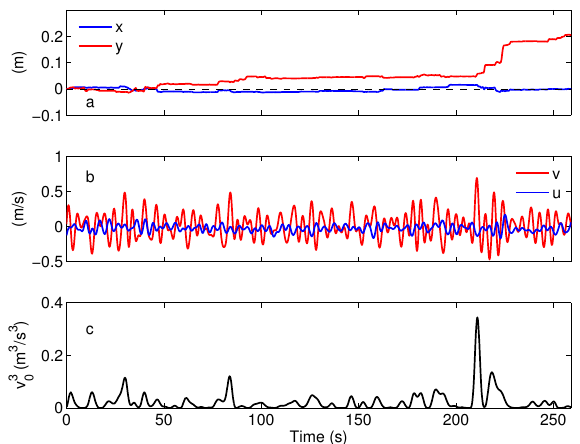
Figure 14. (a) Cross-shore y and along-shore x bed material dis- placements, from the time integral of the MFDop velocities at the range corresponding to peak backscatter from the seabed. (b) Cross- shore v and along-shore u velocities outside the WBBL, from the ADV. (c) The cubed envelope of v (see text).